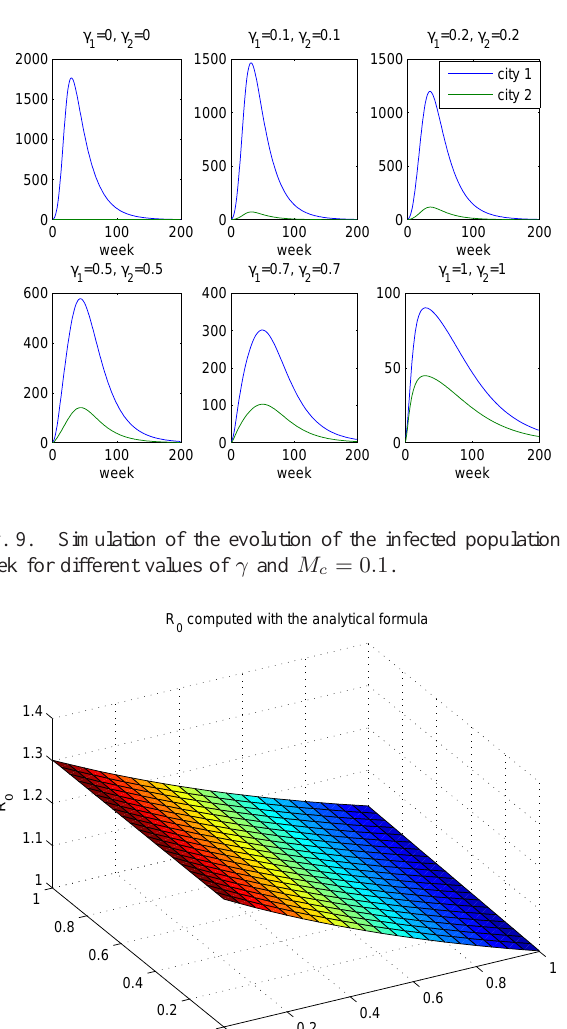
Fig. 10. Evolution of R 2 0 with respect to γ 1 and γ 2 , when M c = 0 . 1